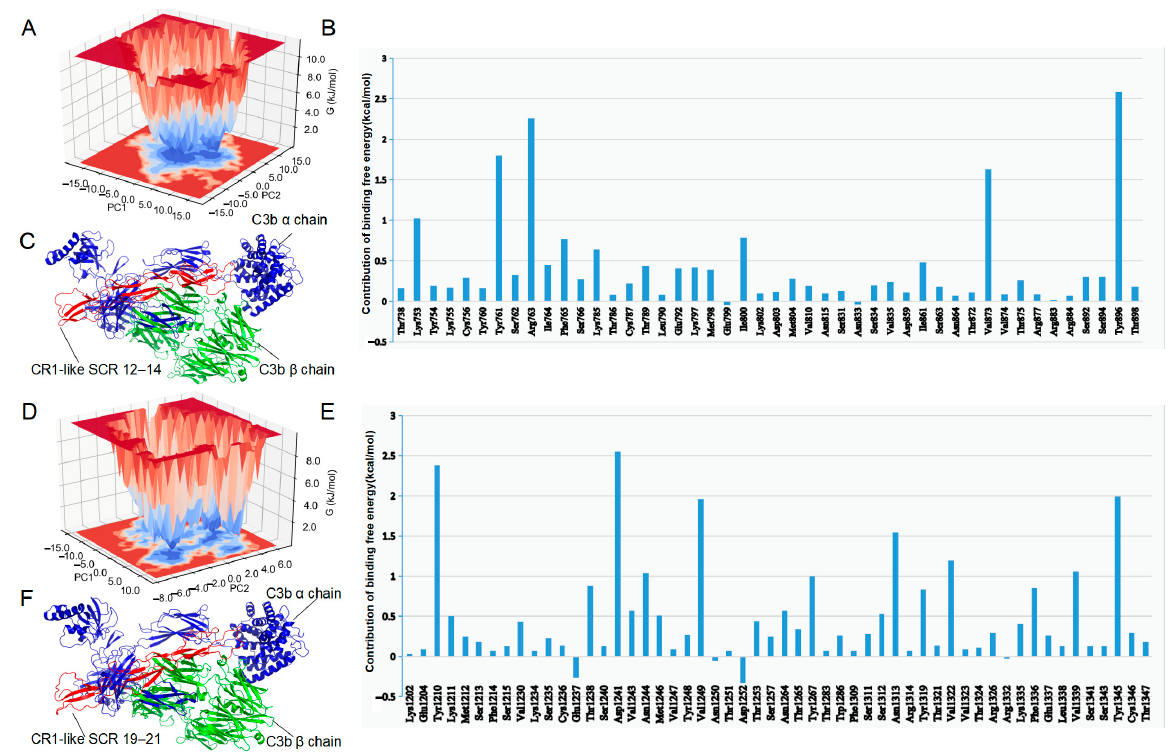
Figure 5. Final structure of the complex and simulated alanine mutation scan. ( A ) PCA-based free energy landscape of the C3b–CR1-like SCR 12–14 complex. ( B ) Simulated alanine mutation scan of C3b–CR1-like SCR 12–14 complex. ( C ) Final structure of the C3b–CR1-like SCR 12–14 complex. ( D ) PCA-based free energy landscape of theC3b–CR1-like SCR 19–21. ( E ) Simulated alanine mutation scan of C3b–CR1-like SCR 19–21 complex. ( F ) Final structure of the C3b–CR1-like SCR 19–21 complex. To further improve the accuracy of the prediction, in addition to the DrugScore PPI server, the KFC, PredHS, and Robetta servers were used for the prediction of CR1-like hotspot residues. The results showed that amino acid residues Tyr761, Arg763, Phe765, Thr789, and Val873 of SCR 12–14 and amino acid residues Tyr1210, Asn1244, Val1249, Thr1253, Tyr1267, Val1322, and Val1339 of SCR 19–21 were all considered by at least three prediction tools to be key residues involved in complex binding (Figure 6A,B). The position of the hotspot residues in the complexes are shown in Figure